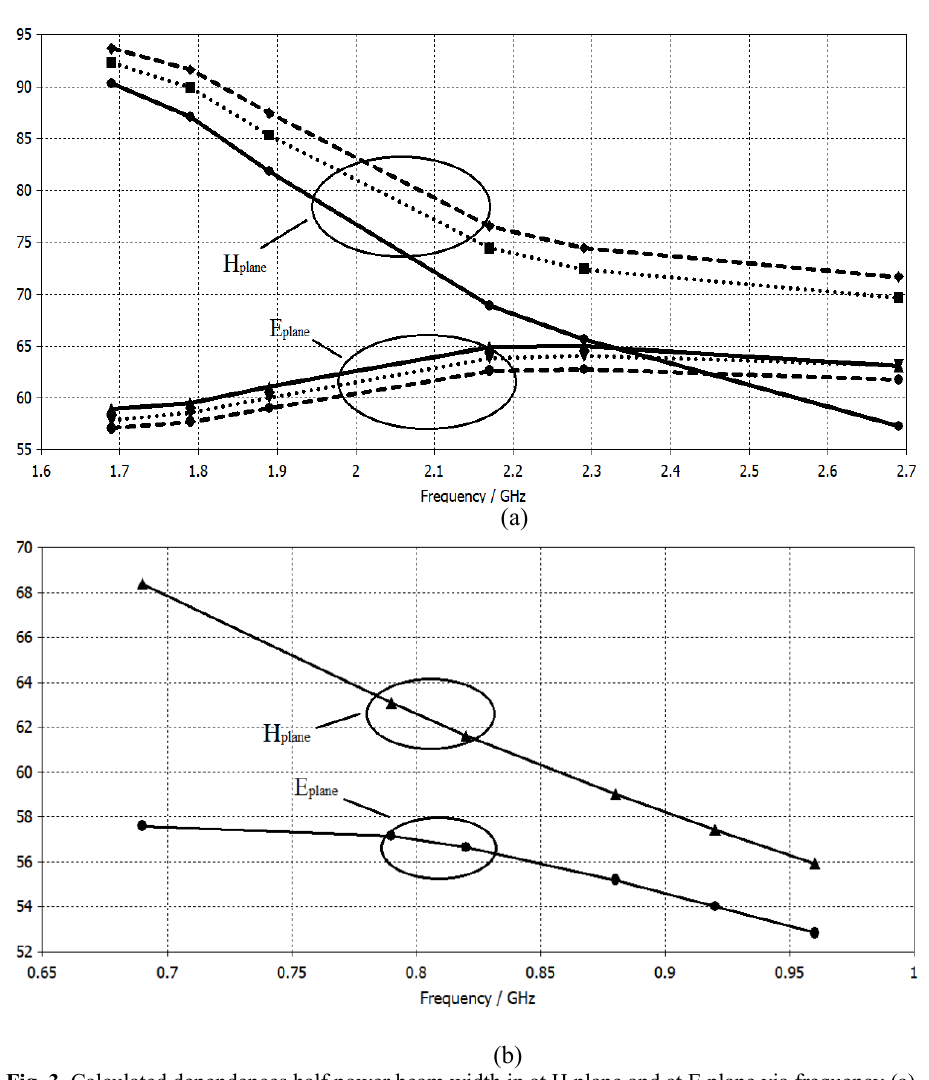
Fig. 3. Calculated dependences half power beam width in at H plane and at E plane via frequency (a) increasing the width of the crossed dipole arm to W˃A/2 for 1695-2695 MHz, (b) Square dipole for 690-960 MHz.